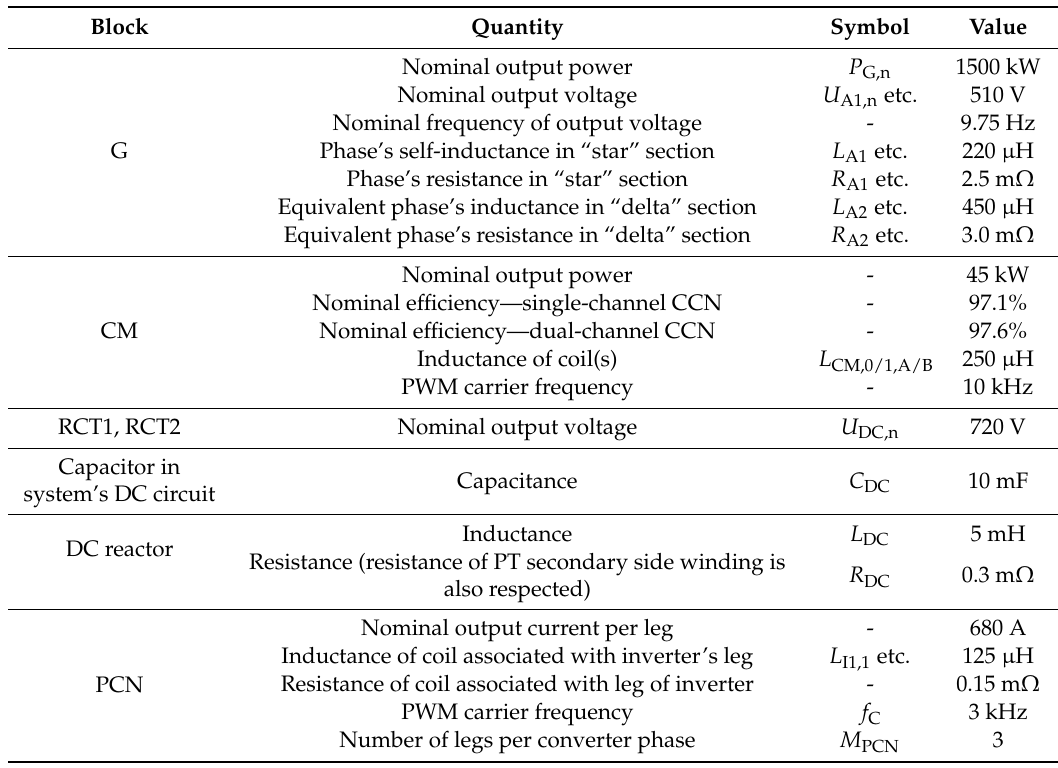
Table 1. Parameters of the MNS for simulation purposes.